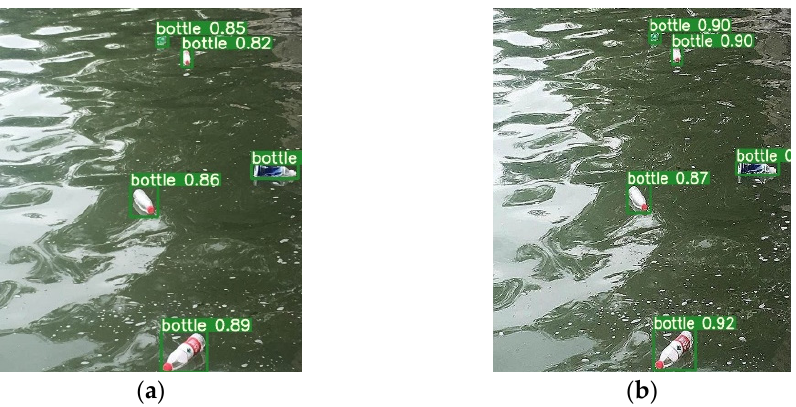
Figure 10. ( a ) Detection result of original image; ( b ) detection result of processed image.